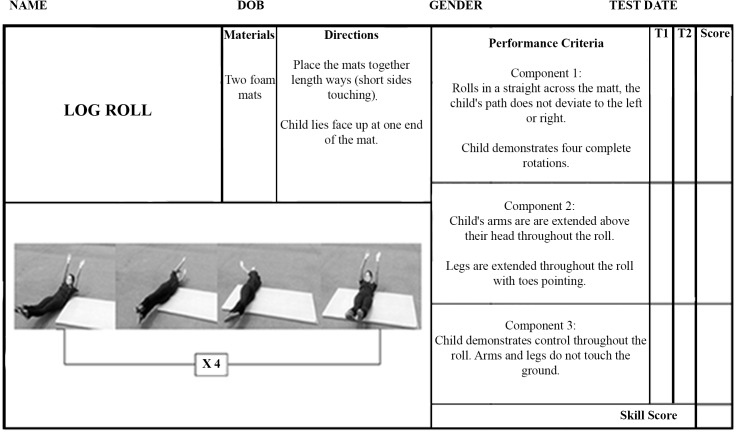
Log-roll scoresheet.